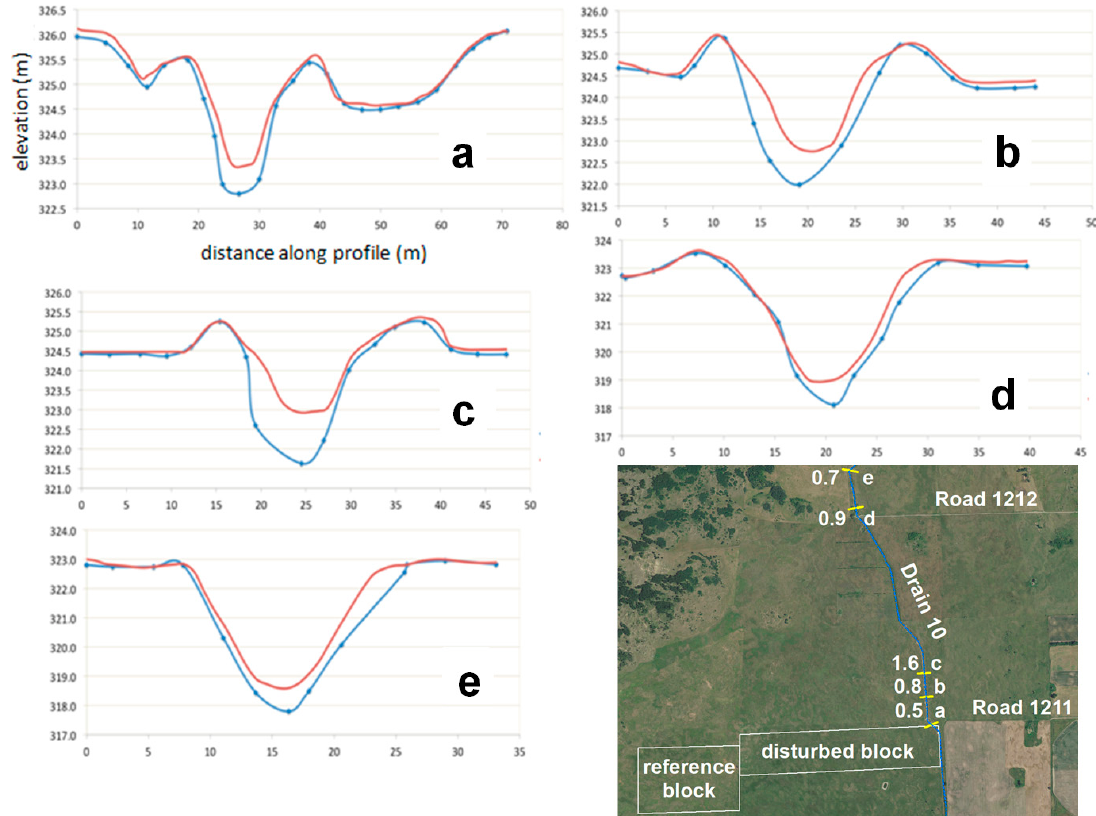
Figure 6. Drain 10 transect profiles (a through e) surveyed in 2017 (blue profiles and points) and compared to data extracted from a 2008 LiDAR-based DEM (red profiles). Transect profile locations along the channel are shown on the aerial image. (imagery obtained from the U.S. Department of Agriculture, Farm Service Agency, acquired 20 August 2013).